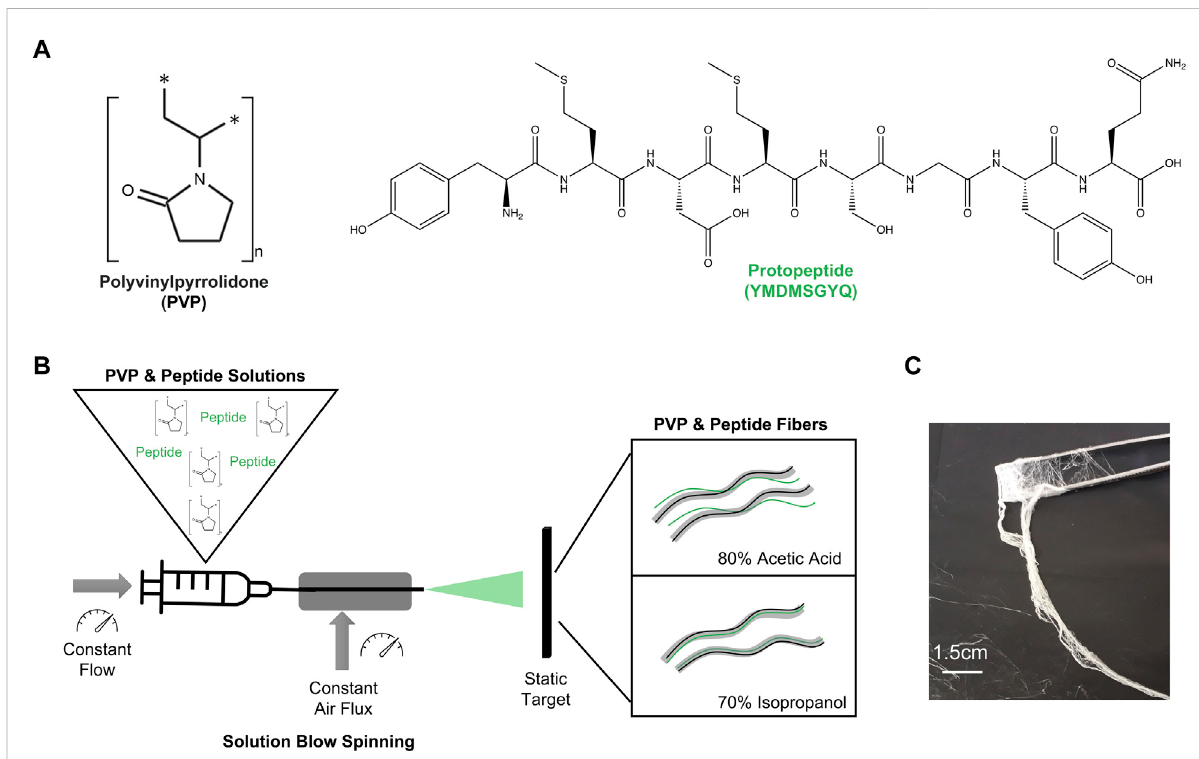
FIGURE 1 (A) Structures of the components used in this work: Polymer — PVP and peptide — Protopeptide; (B) Research strategy to produce fi bers using solutions with polymer and peptide in two different solvents: 80% acetic acid (80:20 (v/v) acetic acid in water) and 70% Isopropanol (70:30 (v/v) isopropanolinwater).Themethodtospunthesolutionsintothe fi berswassolutionblowspinning. (C) Macroscopic fi bersobtainedthroughsolution blow